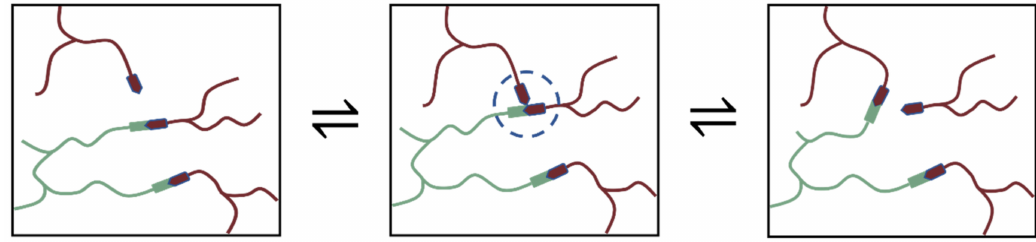
Figure 10. Epoxy vitrimers crosslinked by dynamic transesterification reaction.